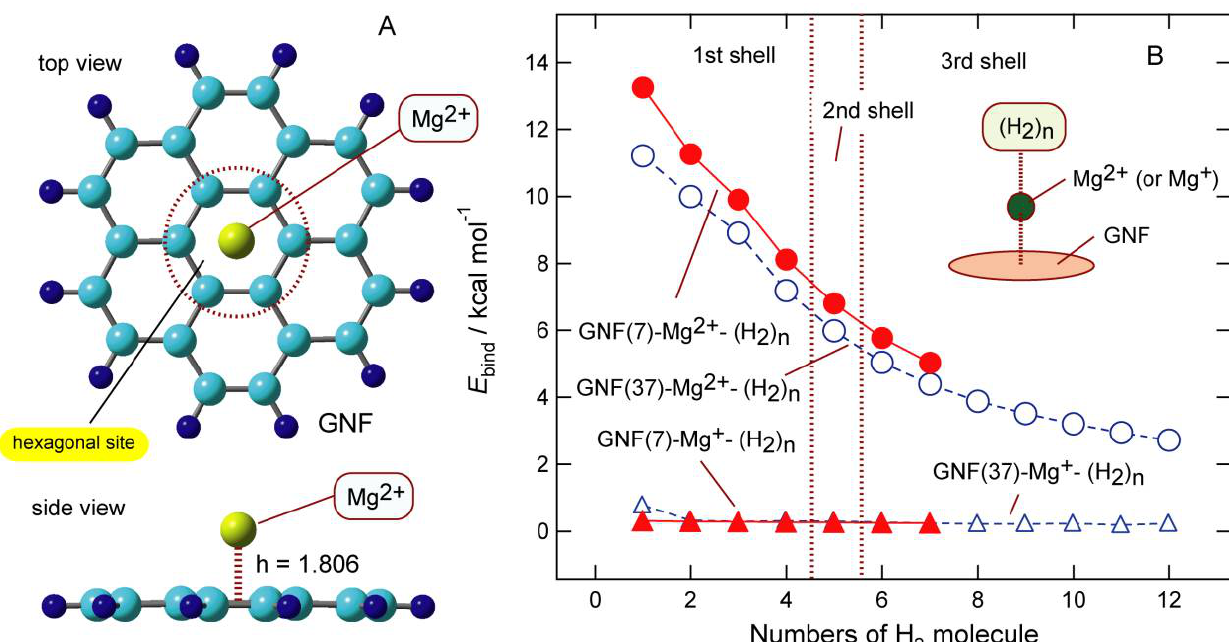
Figure 11. ( A ) The optimized structure of the GNF(7)-Mg 2+ calculated at the CAM-B3LYP/6-311G(d,p) level. Notation h means the height of Mg species from the GNF surface (in Å). ( B ) The binding energies of H 2 to GNF(7)–Mg 2+ and GNF(7)–Mg + (per H 2 molecule) plotted as a function of the number of H 2 molecules ( n ). Dashed lines indicate the binding energies of H 2 to GNF(37)–Mg m+ ( m = 1 and 2). Reprinted with permission from [45]. Copyright 2021 American Chemical Society.